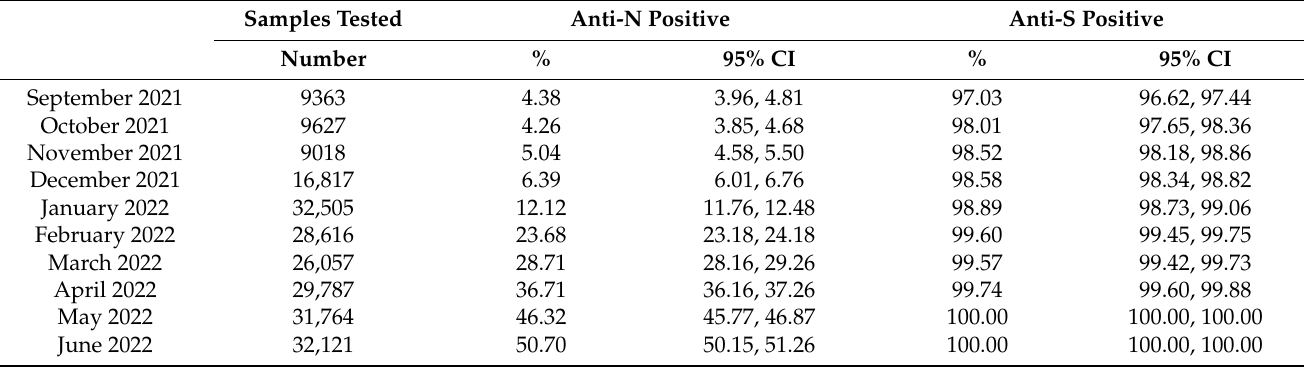
Table A1. Number of samples tested and percentage of samples positive for anti-N and anti-S (weighted and adjusted for test sensitivity and specificity).